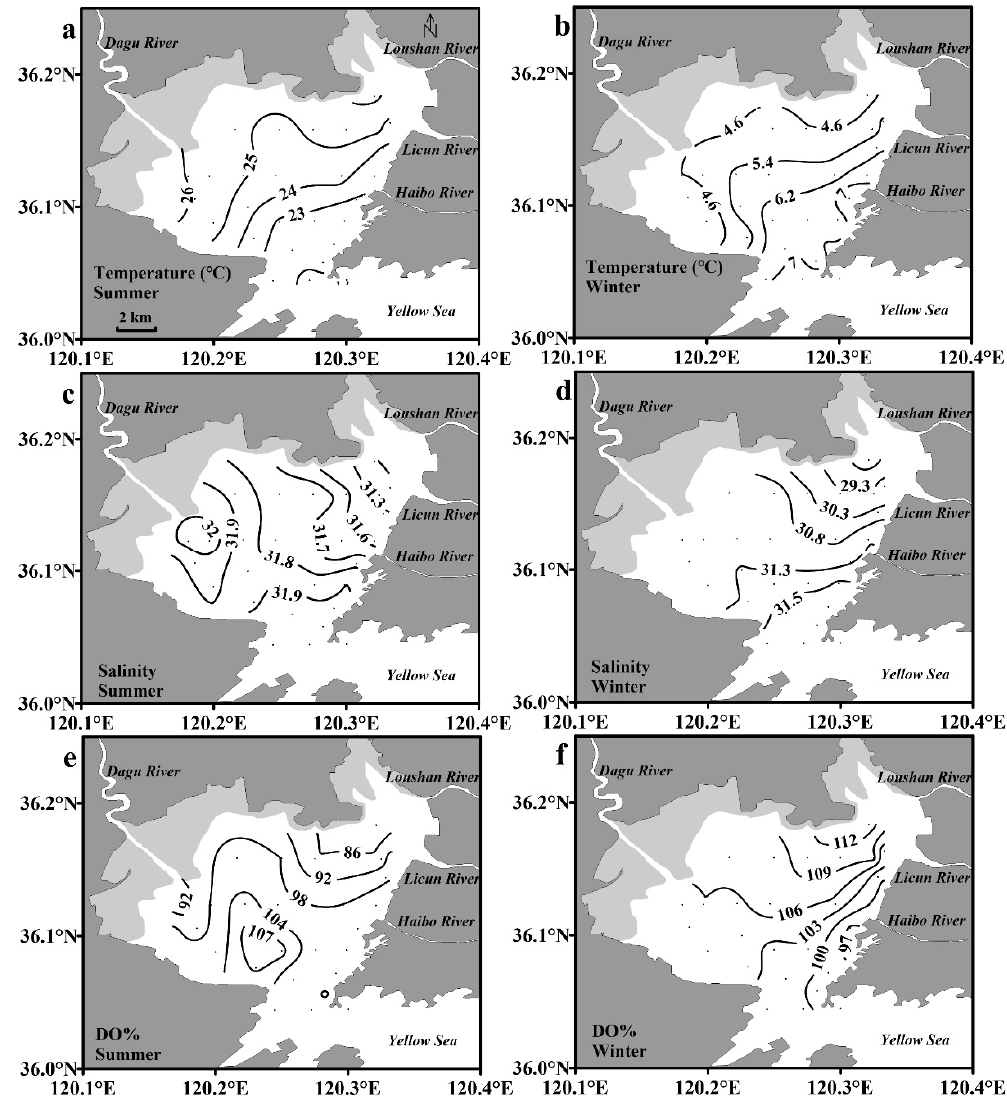
Figure 2. Distributions of seawater surface temperature ( a , b ), salinity ( c , d ) and dissolved oxygen saturation (DO%) ( e , f ) in Jiaozhou Bay (JZB) during summer ( a , c , e , on 28 June 2017) and winter ( b , d , f , on 17 January 2017).